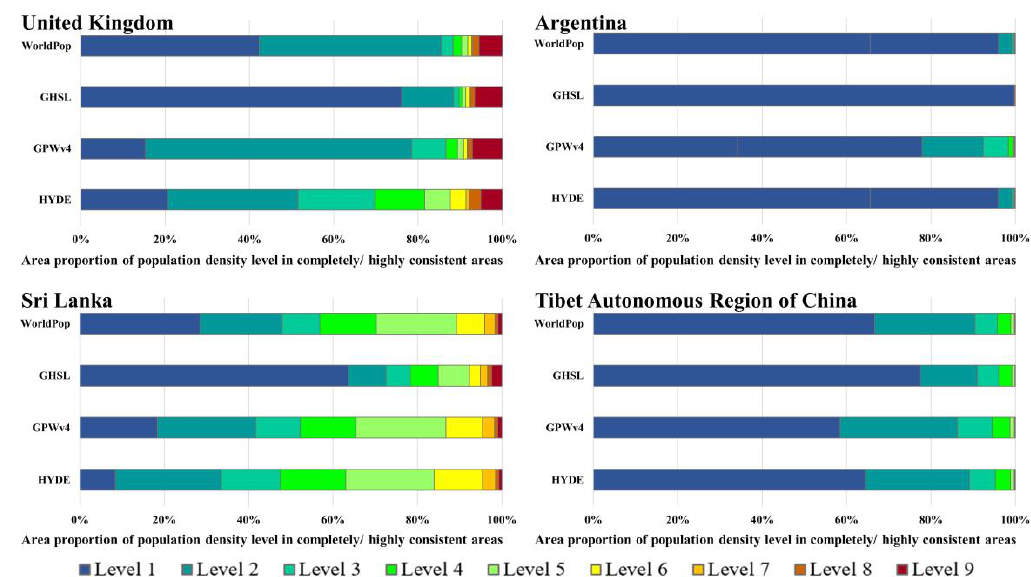
Figure 3. Area proportion of population density level in completely/highly consistent areas.